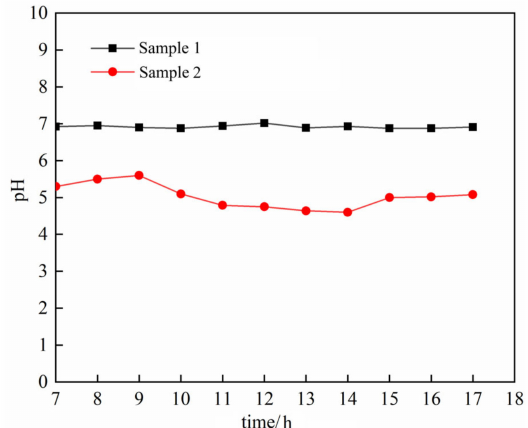
Figure 3. pH in the collected solution during the leaching of ore samples with DI water (sample 1) and (NH 4 ) 2 SO 4